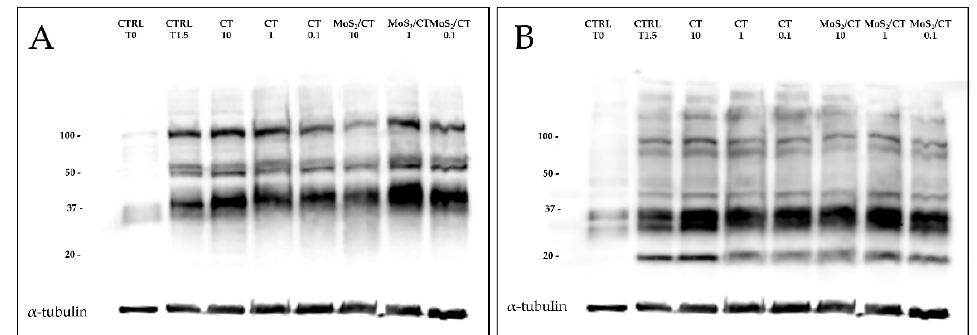
Figure 6. Western blot analysis of PKA activity and tyrosine phosphorylation patterns. The image illustrates ( A ) the PKA activity and ( B ) the tyrosine phosphorylation patterns after 1.5 h of incubation under capacitating conditions. Antibodies were incubated on the same blot after membrane stripping and re-blotting. Blots were cut prior to hybridization. α -tubulin was used as a load control. Each of the eight lanes contains 1 × 10 7 spermatozoa from different animals. At least three independent experiments with different animals were performed.